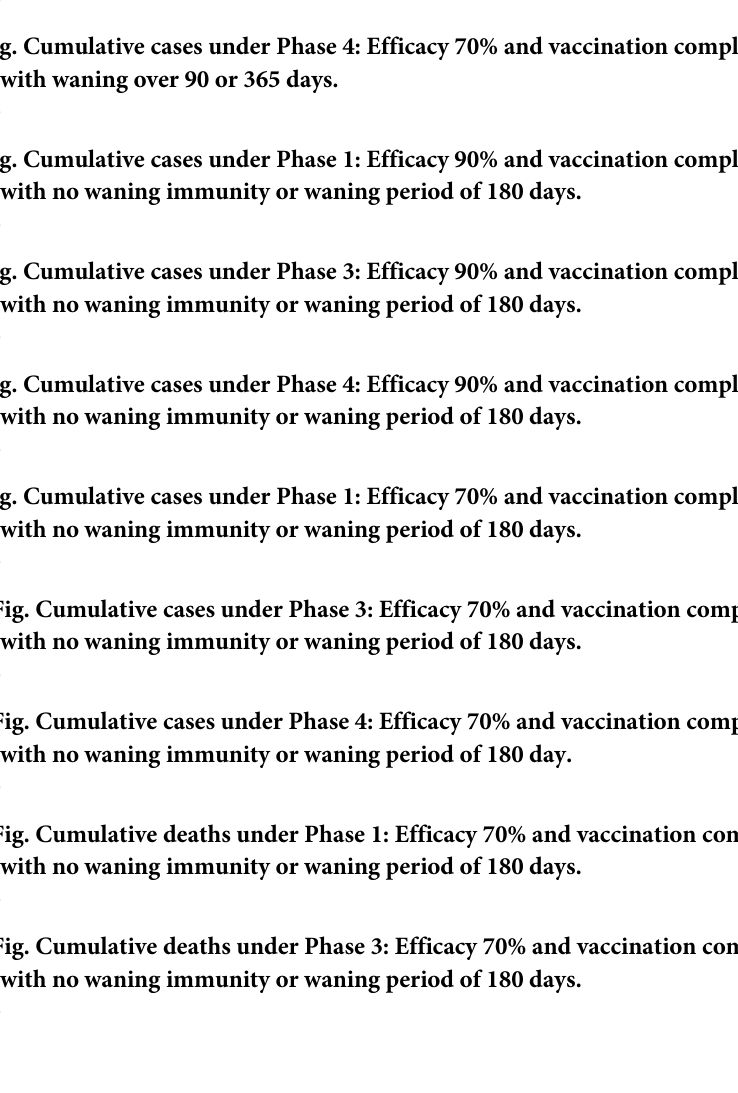
S1 Fig. R 4D contour plot in the β , r , ρ parameters space. The values of the reproduction 0 24 h number are presented under Phase 1 (a), 2 (b), 3 (c) and 4 (d), 0%, 30%,90% vaccine coverage, lifelong immunity and efficacy 90%. S2 Fig. Cumulative cases under Phase 4: Efficacy 70% and vaccination completed in 120 days with no waning immunity or waning period of 180 days. (TIF) S3 Fig. Cumulative cases under Phase 1: Efficacy 70% and vaccination completed in 120 days with waning period of 90 or 365 days. S4 Fig. Cumulative cases under Phase 3: Efficacy 70% and vaccination completed in 120 days with waning over 90 or 365 days. S5 Fig. Cumulative cases under Phase 4: Efficacy 70% and vaccination completed in 120 days with waning over 90 or 365 days. S6 Fig. Cumulative cases under Phase 1: Efficacy 90% and vaccination completed in 120 days with no waning immunity or waning period of 180 days. (TIF) S7 Fig. Cumulative cases under Phase 3: Efficacy 90% and vaccination completed in 120 days with no waning immunity or waning period of 180 days. (TIF) S8 Fig. Cumulative cases under Phase 4: Efficacy 90% and vaccination completed in 120 days with no waning immunity or waning period of 180 days. (TIF) S9 Fig. Cumulative cases under Phase 1: Efficacy 70% and vaccination completed in 360 days with no waning immunity or waning period of 180 days. (TIF) S10 Fig. Cumulative cases under Phase 3: Efficacy 70% and vaccination completed in 360 days with no waning immunity or waning period of 180 days. S11 Fig. Cumulative cases under Phase 4: Efficacy 70% and vaccination completed in 360 days with no waning immunity or waning period of 180 day. S12 Fig. Cumulative deaths under Phase 1: Efficacy 70% and vaccination completed in 120 days with no waning immunity or waning period of 180 days. S13 Fig. Cumulative deaths under Phase 3: Efficacy 70% and vaccination completed in 120 days with no waning immunity or waning period of 180